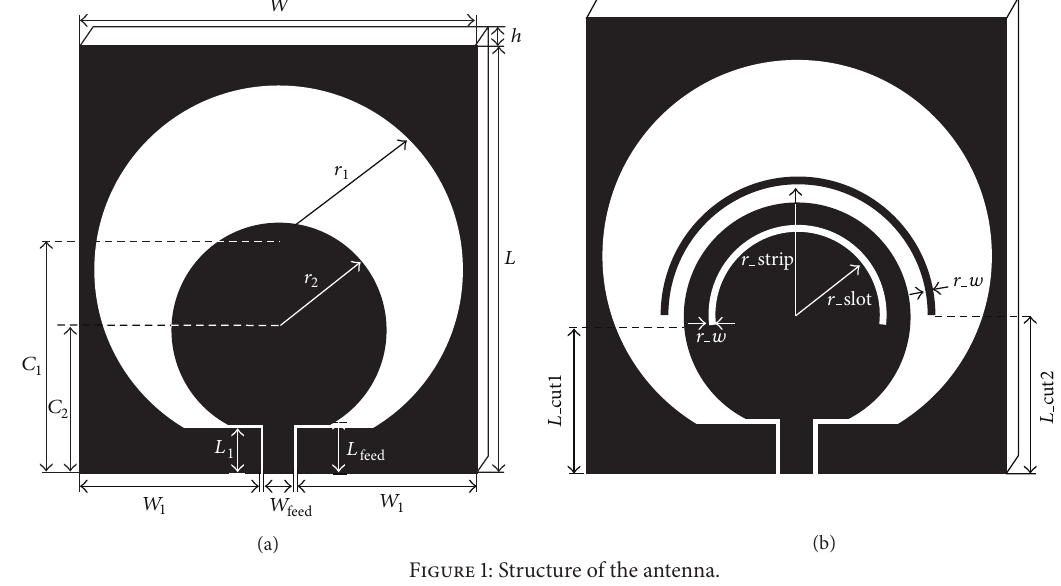
Figure 1: Structure of the